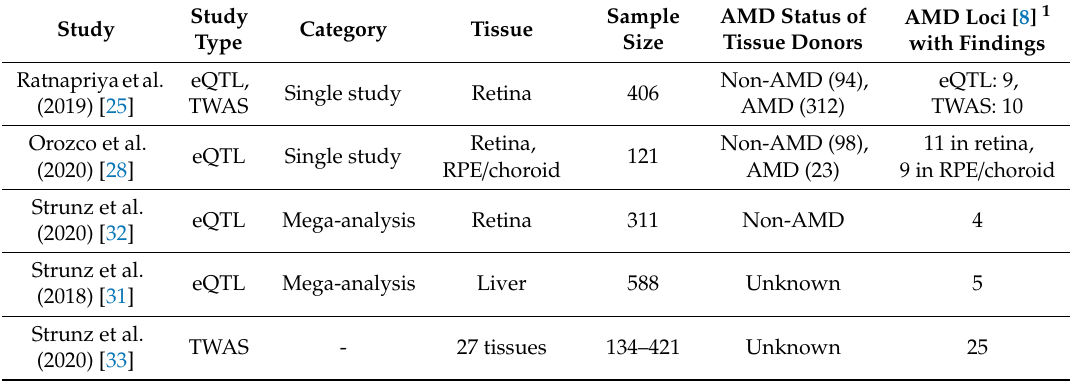
Table 1. Studies investigating AMD association data in the context of gene expression regulation. Sample AMD Status of Study AMD Loci [8] 1 Category Tissue Study Size Tissue Donors Type with Findings Ratnapriyaetal. Non-AMD (98), 11 in retina, Retina, RPE / choroid 9 in RPE /